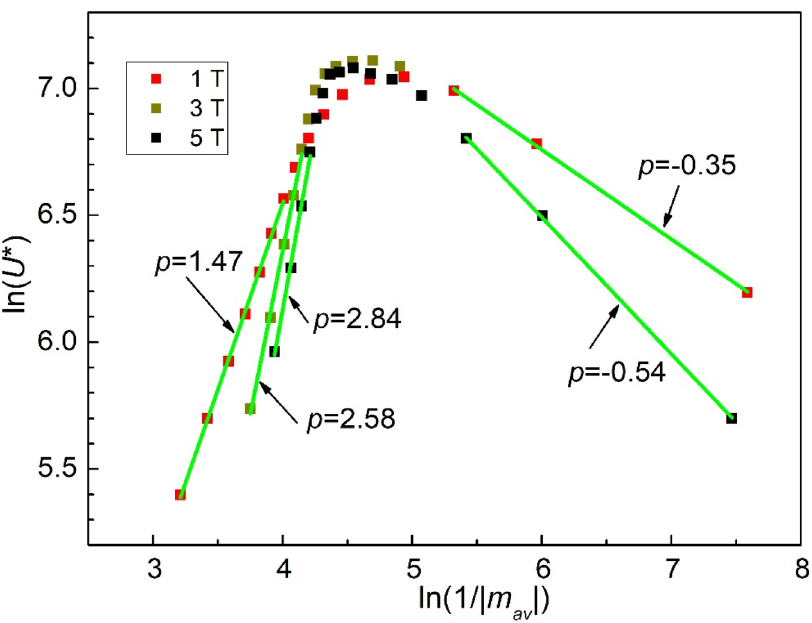
Figure 4. Dependence of the normalized pinning potential U * on the inverse of irreversible magnetization averaged over t w , in double logarithmic plot, for the three DC magnetic fields indicated in the figure. The slopes of the straight lines in the figure represent the vortex creep exponent p in Eq. (2), positive values indicating elastic creep, while negative values indicating plastic